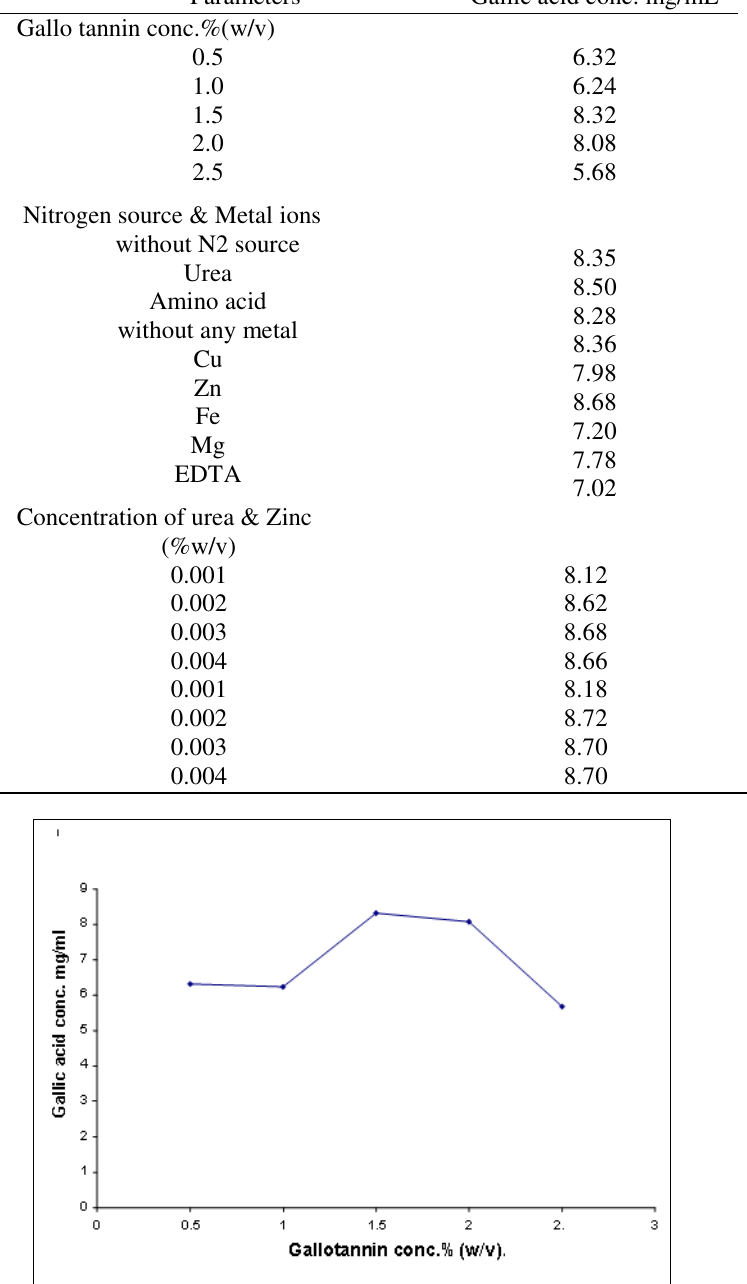
Figure 1 . Effect of gallotannin concentration on gallic acid